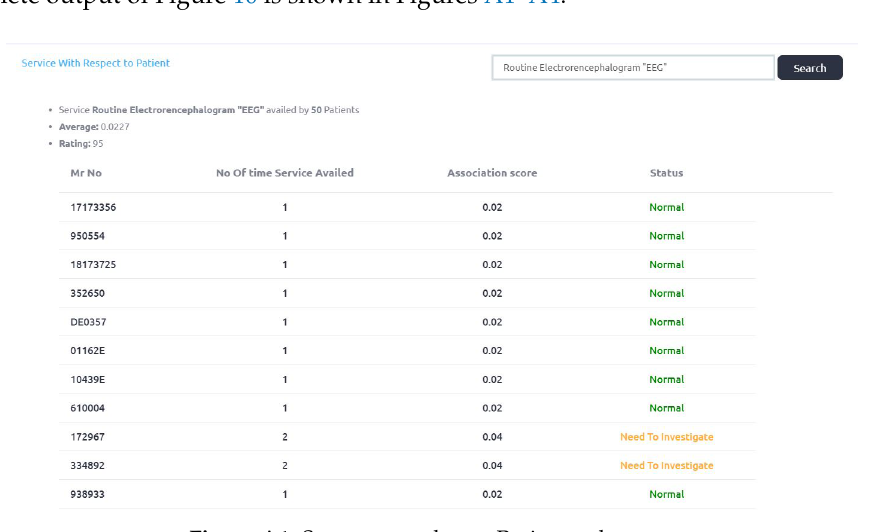
Figure A1. Servuce wrt doctor Rating and status.